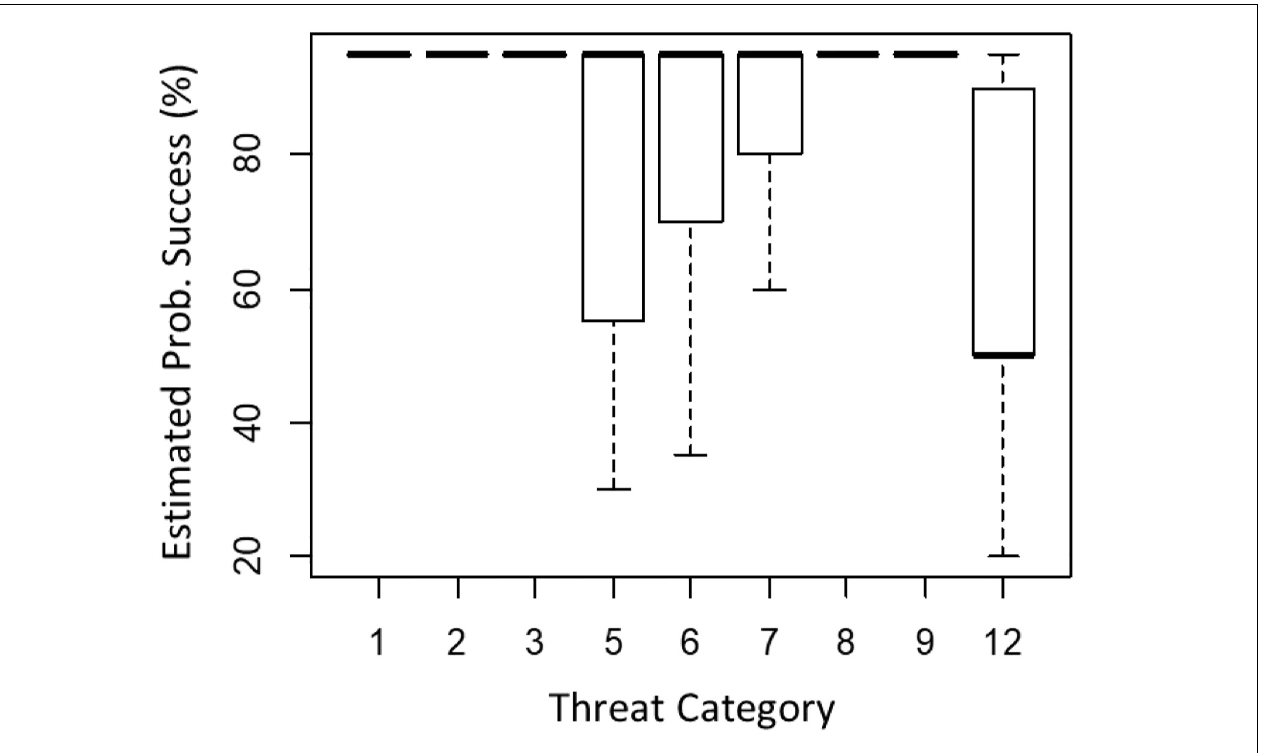
FIGURE 2 | Estimated probabilities of success addressing each threat category for New Zealand. Results for New South Wales and United States were non-significant ( Supplementary Tables S3, S4 ). Threat categories are as for Figure 1 (see Table 1A and Supplementary Table S1 for details).